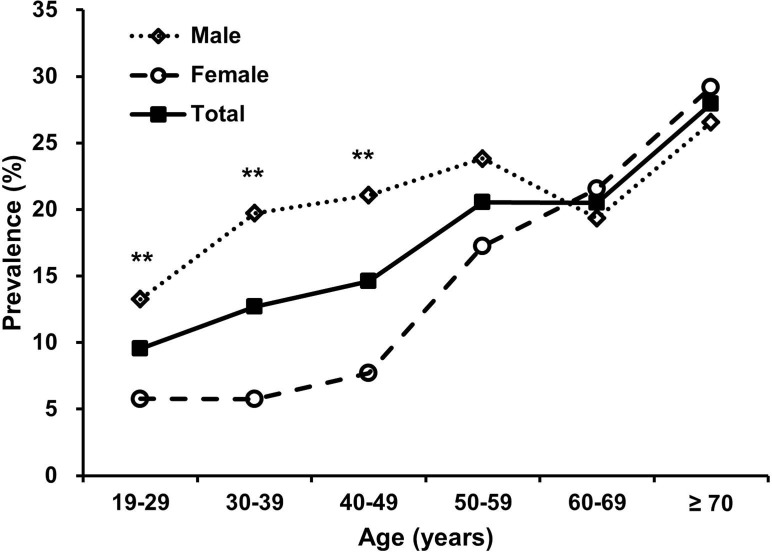
Prevalence of a high risk for obstructive sleep apnea according to age and sex.High risk for obstructive sleep apnea was defined as positive symptom categories of ≥ 2 on the Berlin questionnaire. *P < 0.05 and **P < 0.01 for comparisons between male and female in each age group. n = 1,368 in male and n = 1,372 in female.